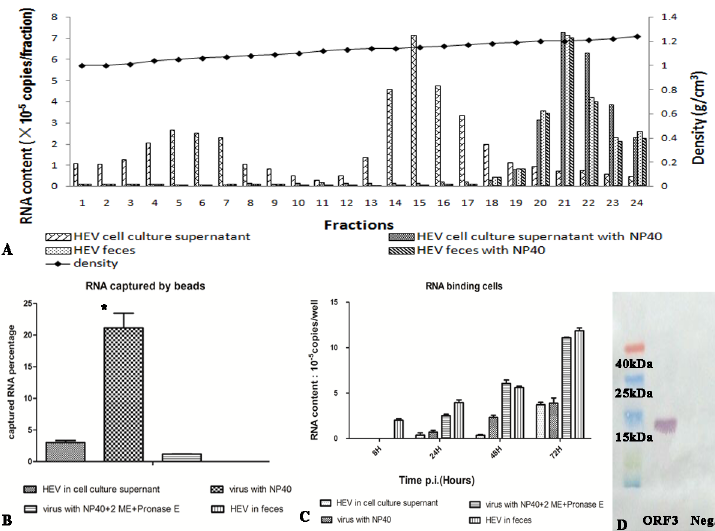
Fig 3. The analysis of the fraction rich inHEV RNA. (A) The density-gradient fraction of virus from different sources and with different treatments. The X-axis is the fraction number and the right Y-axis is the density of the fraction. The left Y-axis is the HEV RNA content. (B) The binding ability of virus to anti-ORF3 MAb, the Y- axis is the percentage of binding HEV RNA to total HEV RNA of sample. The * represents the P value of HEV virus in the cell culture supernatant with NP40 treatment compared to the same sample without NP40 treatment. P value is less than 0.05. (C) The binding effect of virus to cells, the X-axis is the time post incubation with samples and the Y-axis was the binding RNA content to cells. (D) The fraction 15 of cell culture supernatant was detected by western blotting with an anti-ORF3